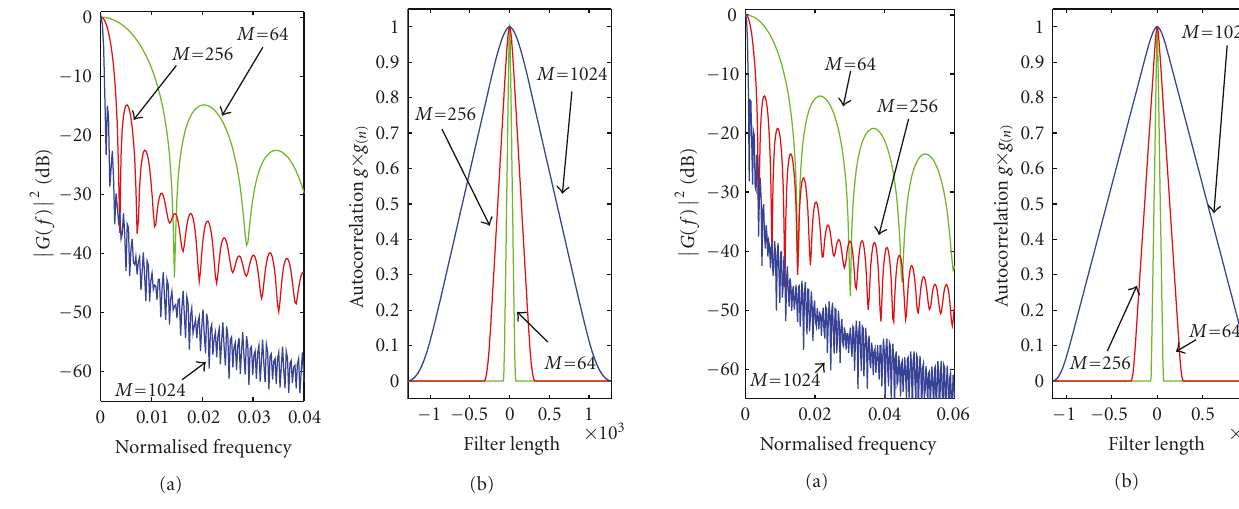
Figure 10: Frequency response and pulse autocorrelation for parameters M 0 = 4, N 0 = 5, and L f = N .